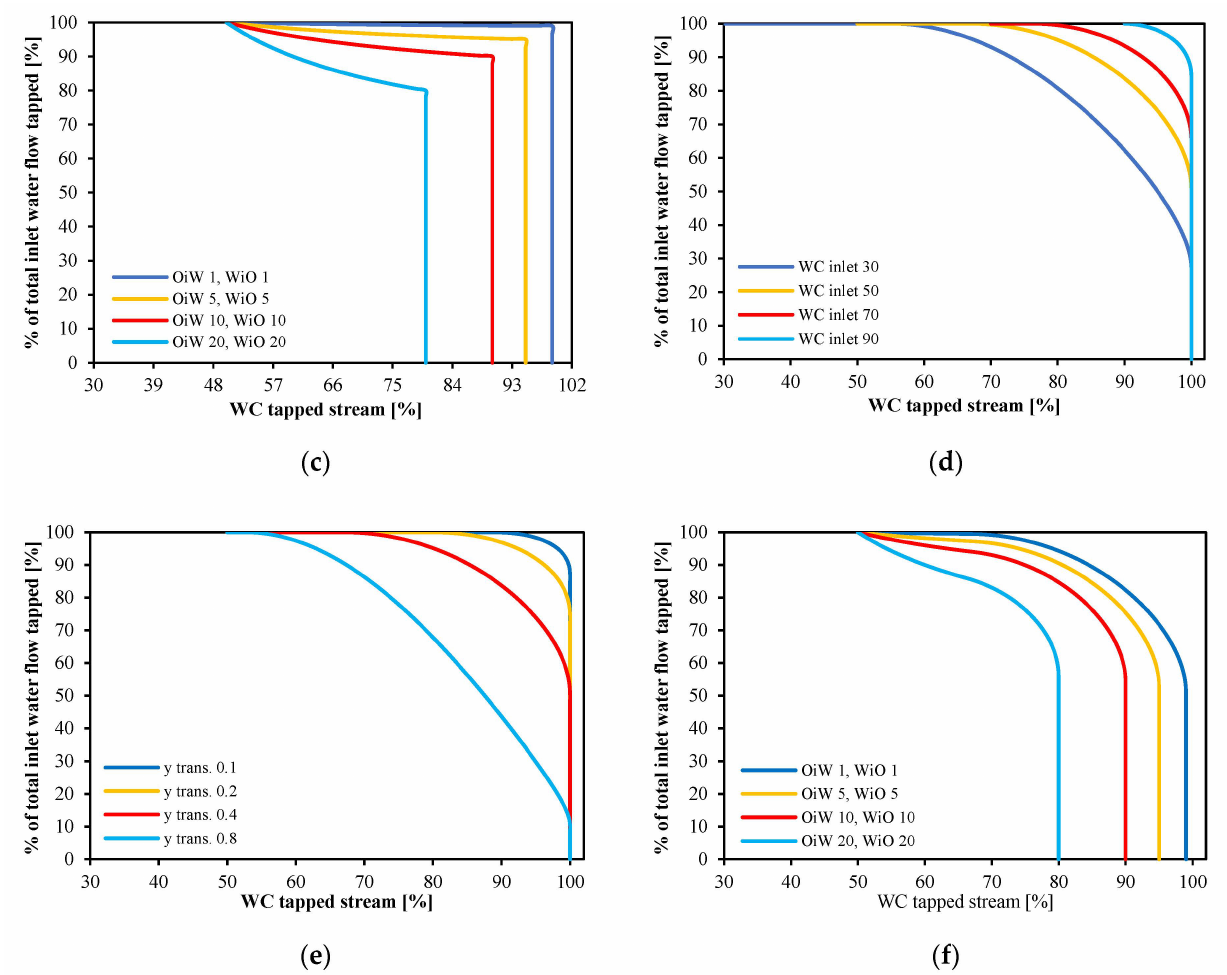
Figure 16. Model prediction of drainage potential curve for a certain ( a ) step volume fraction of water and WC inlet 70%, ( b ) step volume fraction of water with 5% uniform contamination of WiO and OiW and various WC inlet 30%, 50%, 70%, 90%, ( c ) step volume fraction of water with different uniform contamination 1, 5, 10, and 20% of WiO and OiW, WC inlet 50%, ( d ) linear water volume fraction change in phase distribution of transition zone with 0.4 normalized width for four different WC inlet 30%, 50%, 70%, 90%, ( e ) linear water volume fraction change in phase distribution of transition zone with different normalized width 0.1, 0.2, 0.4, 0.8 WC inlet 50%, ( f ) linear water volume fraction change in phase distribution of transition zone with normalized width of 0.4 and uniform contamination 1, 5, 10, and 20% of WiO and OiW, WC inlet